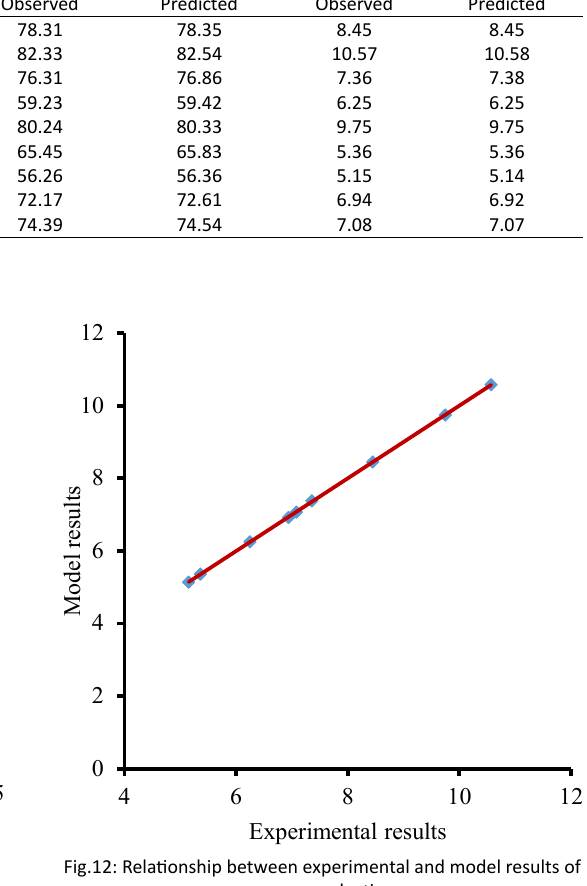
Table 10: Experimental and model results for COD reduction and power production Experimental runs